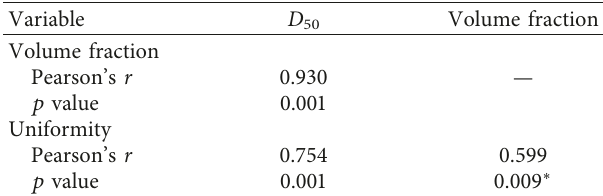
Table 4: Pearson’s r correlation and significance degree of cor- relation among the physical characteristics of spray-dried powder.